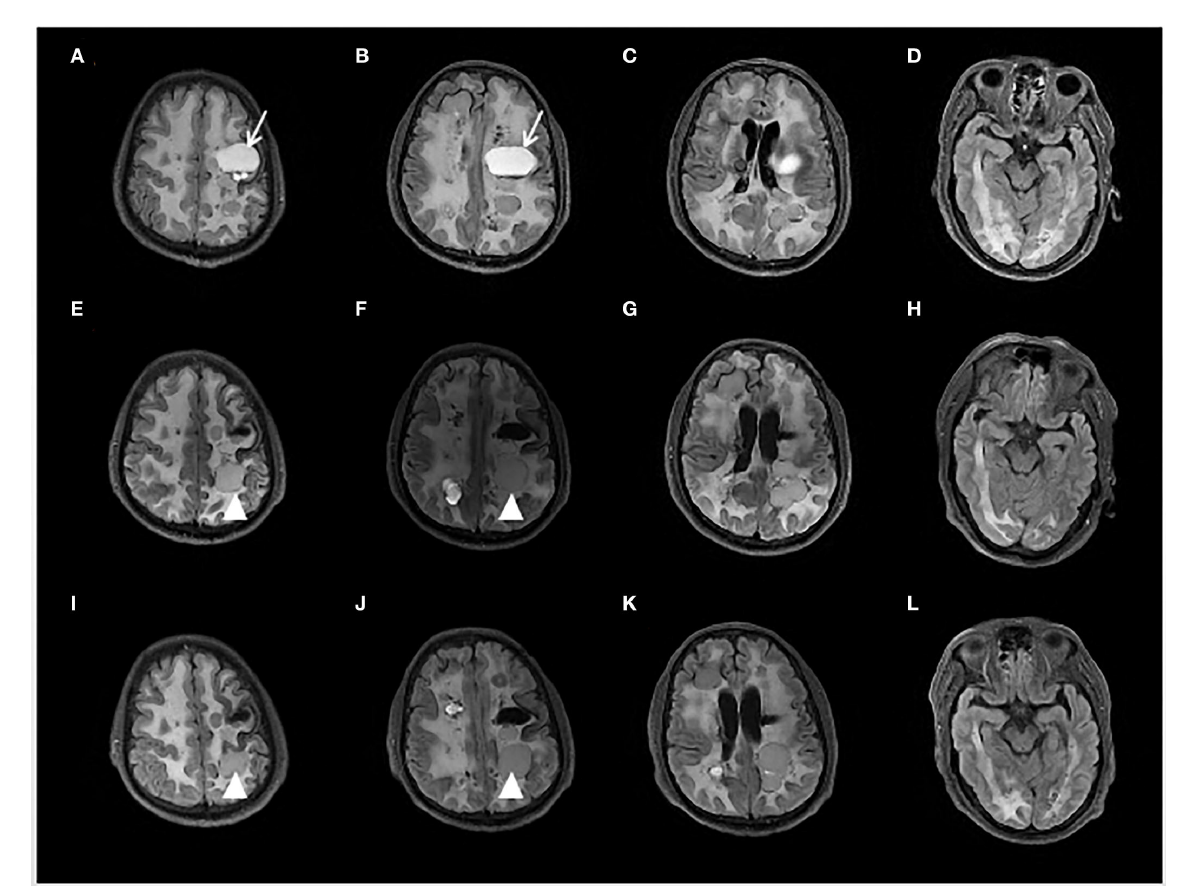
FIGURE1 Brain fluid-attenuated inversion recovery (FLAIR) sequence of initial presentation (A–D) , 6 months (E–H) , and 12 months (I–L) after Bevacizumab treatment. The initial MRI showed multiple cystic foci and white matter lesions in bilateral cerebral hemispheres. The left mass cystic foci [showed as an arrow in (A,B) ] was decompressed by an Ommaya reservoir. After 6 months treatment of Bevacizumab, another left frontal lobe cystic foci [showed as an arrowhead in (E,F,I,J) ] was slightly